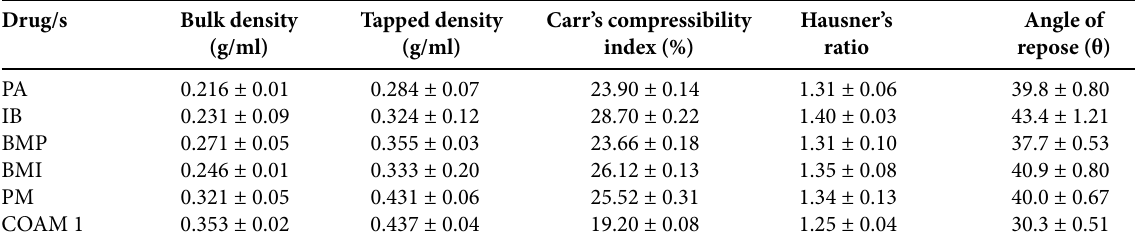
Table 2. Data for micromeritic properties of PA and IB (API, separately ball milled API, physical mixture, COAM 1) Drug/s Bulk